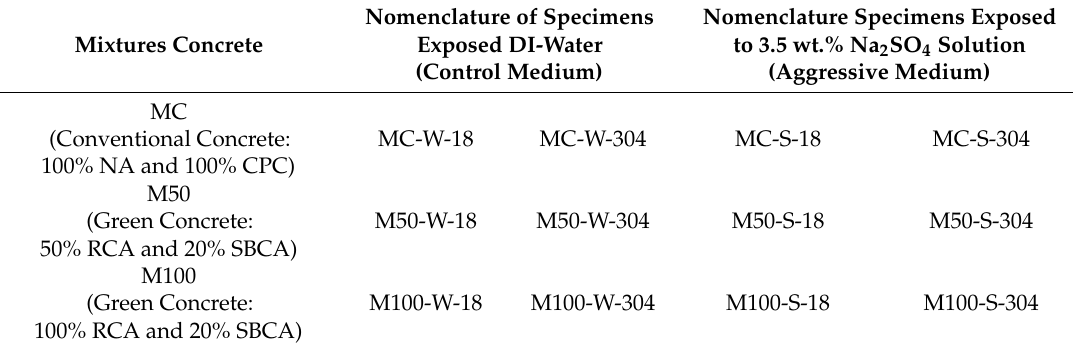
Table 6. Nomenclature of the reinforced green concrete specimens for electrochemical